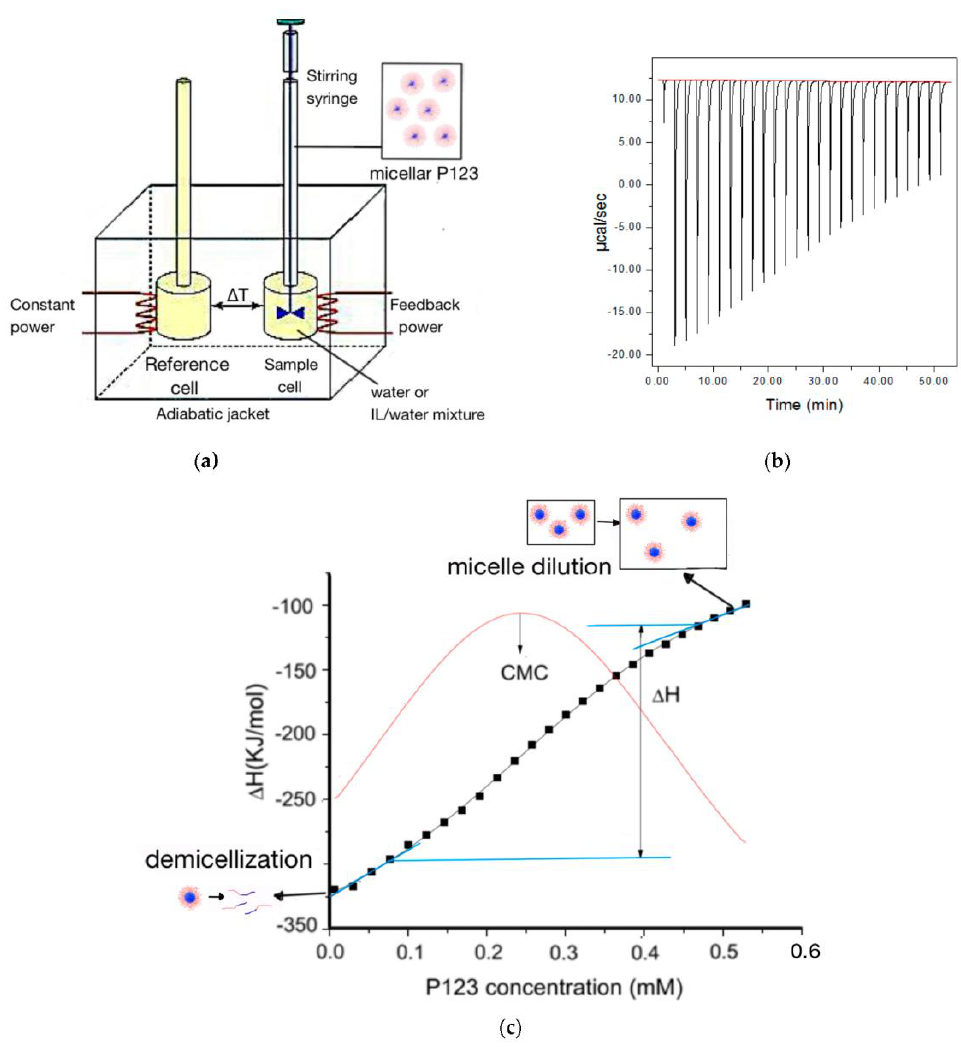
Figure 1. ( a ) Schematic of the titration process for micellization in an isothermal titration calorimeter. Micellar Plurnic P123 inside the syringe is titrated into the sample cell, which contains water or water + ethylammonium nitrate (EAN) solution. ITC records the heat difference between the sample cell and reference cell caused by the dilution and dissociation of injected micelles at constant temperature. ( b ) Raw ITC data of aqueous micellar Pluronic P123 solution titrated into water at 20 °C. ( c ) Enthalpy change during micellar Pluronic P123 solution titrated into water plotted versus Pluronic P123 concentration in the sample cell at 20 °C. The large heat release for the initial injections indicated that all the titrated micelles dissociate into unimers; the relative small heat release over the last injections indicated that the injected micelles only diluted without dissociation. The enthalpy of micellization is determined by the difference between the enthalpy value of extrapolation at the end of the first few injections and the start of the last few injections.